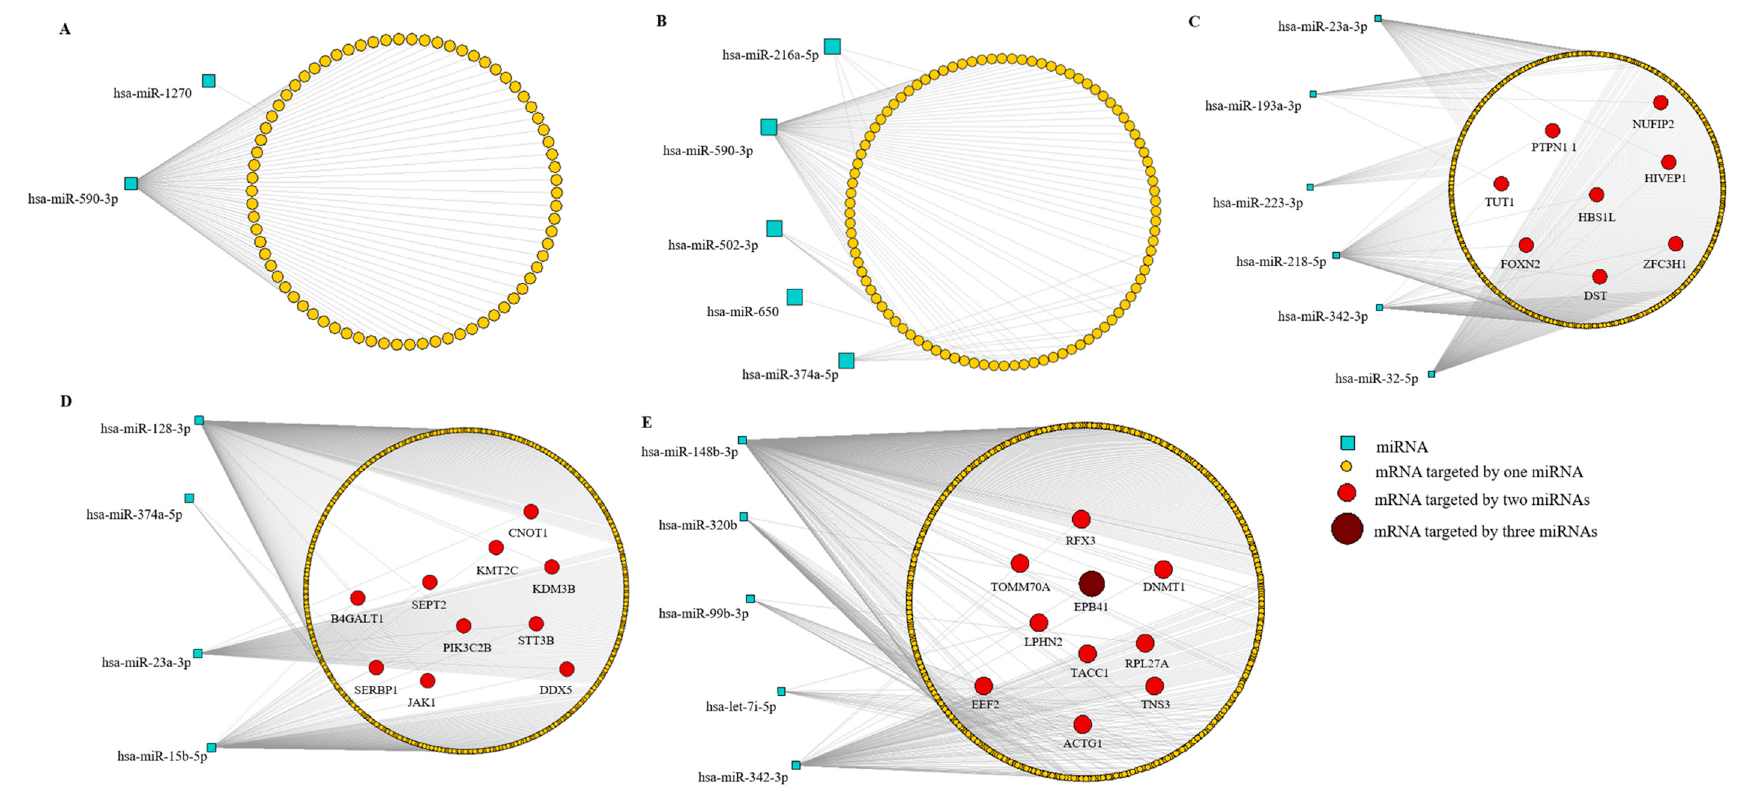
Figure 5. MiRNA-mRNA interaction networks to identify regulatory interactions between miRNAs and mRNA in cells infected with yeasts from distinct H. capsulatum strains. Interaction networks were constructed with the Navigator software v2.2 from triplicate analyses. Differentially expressed miRNAs were analyzed using the miRWalk software. MiRNAs are represented by squares and the target genes are represented through their mRNAs by circles. The grey lines connect miRNAs to their target mRNAs. Most mRNAs (yellow circles) are targeted by a single specific miRNA, whereas the remaining mRNAs, represented in red and dark red circles, are regulated by two or three distinct miRNAs, respectively. Analyses were performed between ( A ) THP-1 Mø-like cells infected with the 60I strain grown in planktonic form vs. uninfected THP-1 Mø-like cells (control); ( B ) THP-1 Mø-like cells infected with the EH-315 strain vs. THP-1 Mø-like cells infected with the 60I strain, both grown in planktonic form; ( C ) THP-1 Mø-like cells infected with the EH-315 strain grown in planktonic form vs. uninfected THP-1 Mø-like cells (control); ( D ) THP-1 Mø-like cells infected with the EH-315 strain grown in biofilm form vs. THP-1 Mø-like cells infected with the EH-315 strain grown in planktonic form; and ( E ) THP-1 Mø-like cells infected with the EH-315 strain grown in biofilm form vs. uninfected THP-1 Mø-like cells (control).